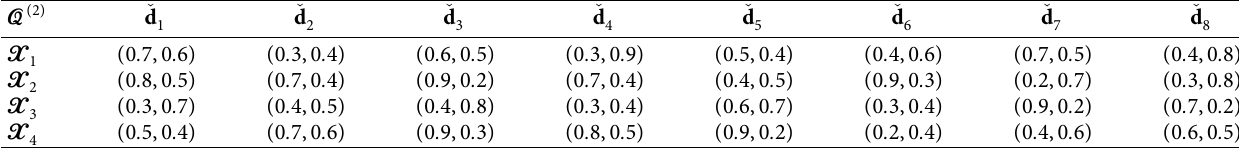
Table 2: Decision matrix for alternative Q ( 2 ) .